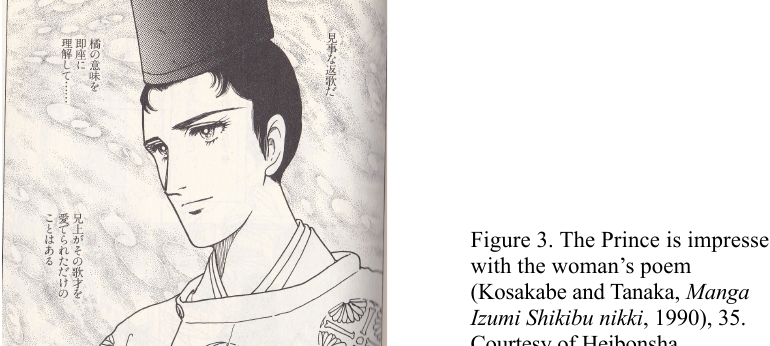
Figure 3. The Prince is impressed